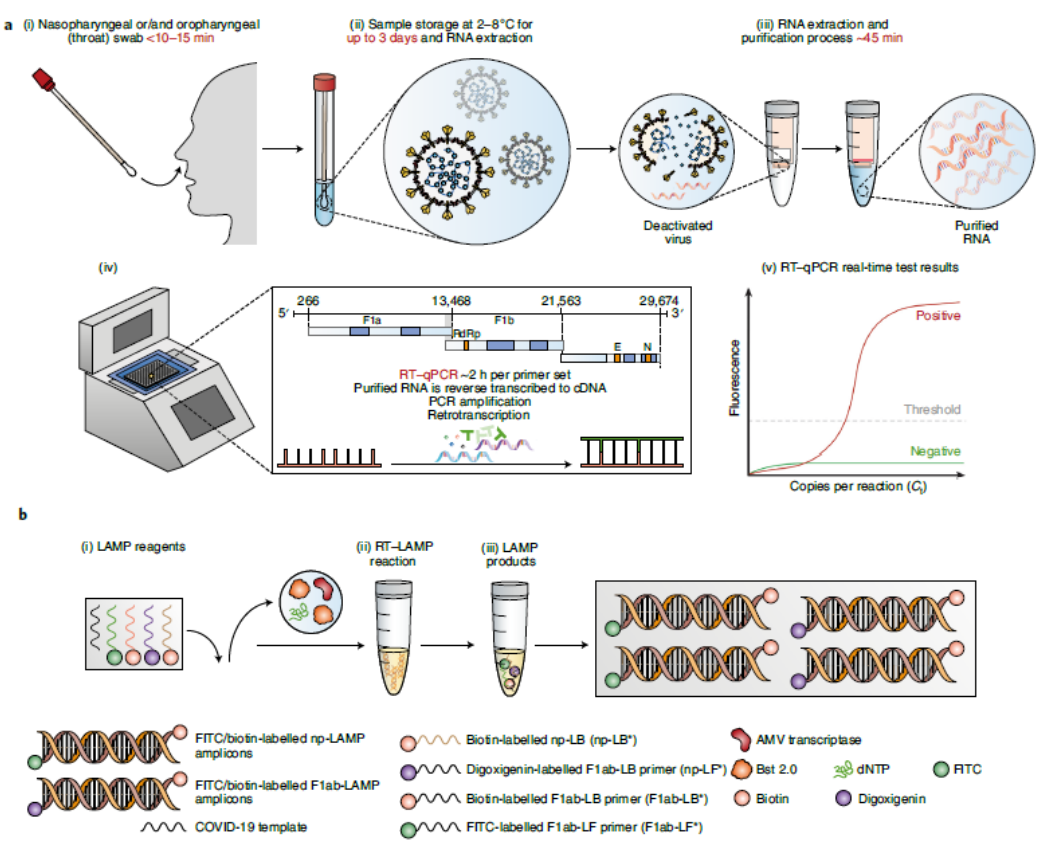
Figure 5. Different types of RNA detection methods, such as ( a ) RT-PCR testing and ( b ) SARS-CoV- 2 RT-LAMP testing. Reprinted with permission from Springer Nature [32], Copyright (2021).